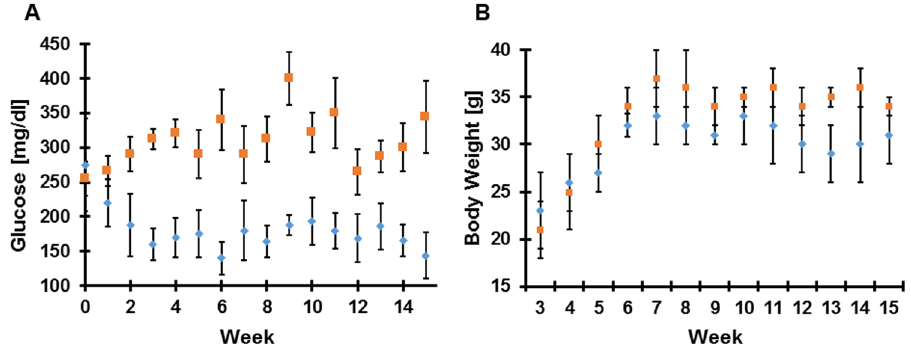
Figure 1. Immunization with hIAPP oligomer reduces the T2DM phenotype. ( A ) Mice received intraperitoneal injections of hIAPP oligomers (blue diamond) or vehicle (red squares), along with an adjuvant. Blood glucose levels were evaluated every 7 days. As shown, there was a statistically significant difference between the mock and treated groups (N = 13 in each group, values are means ± s.d). ( B ) Body weight measurements over time in mice receiving vehicle (red squares) and treatment (blue diamond, N = 10 in each